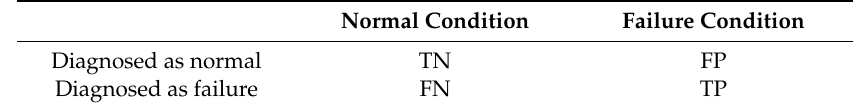
Table 4. Confusion